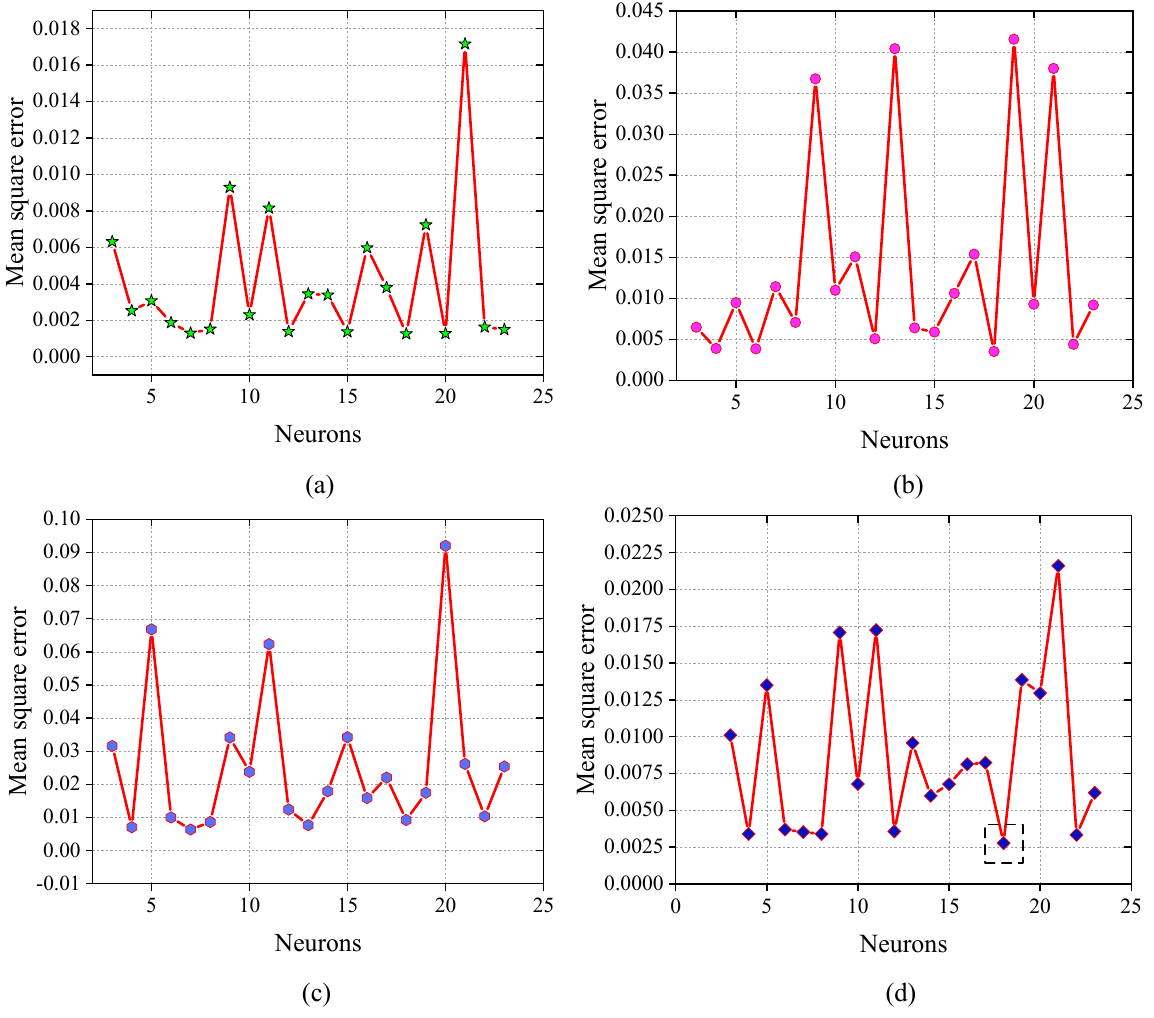
Figure 5. Selection of best neuron based on MSE-value (normalized values) ( a ) Training, ( b ) Validation, ( c ) Testing and ( d ) All dataset.